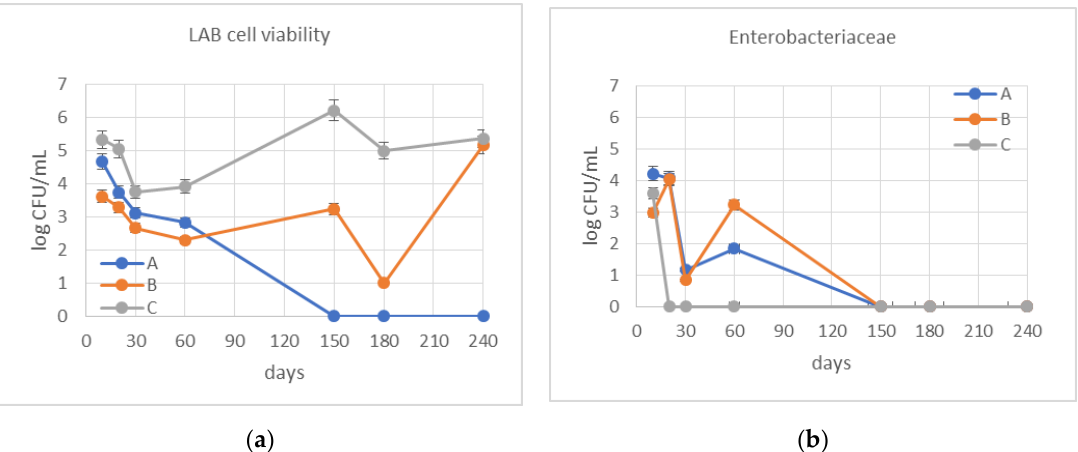
Figure 3. LAB cells’ viability ( a ) and the trend of the growth of Enterobacteriaceae ( b ) during the fermentation. A = spontaneous; B = inoculated with L. plantarum B1; C = inoculated with L. plantarum B1 + B51 + B124. The data are expressed as mean of two replicates ± standard deviation.